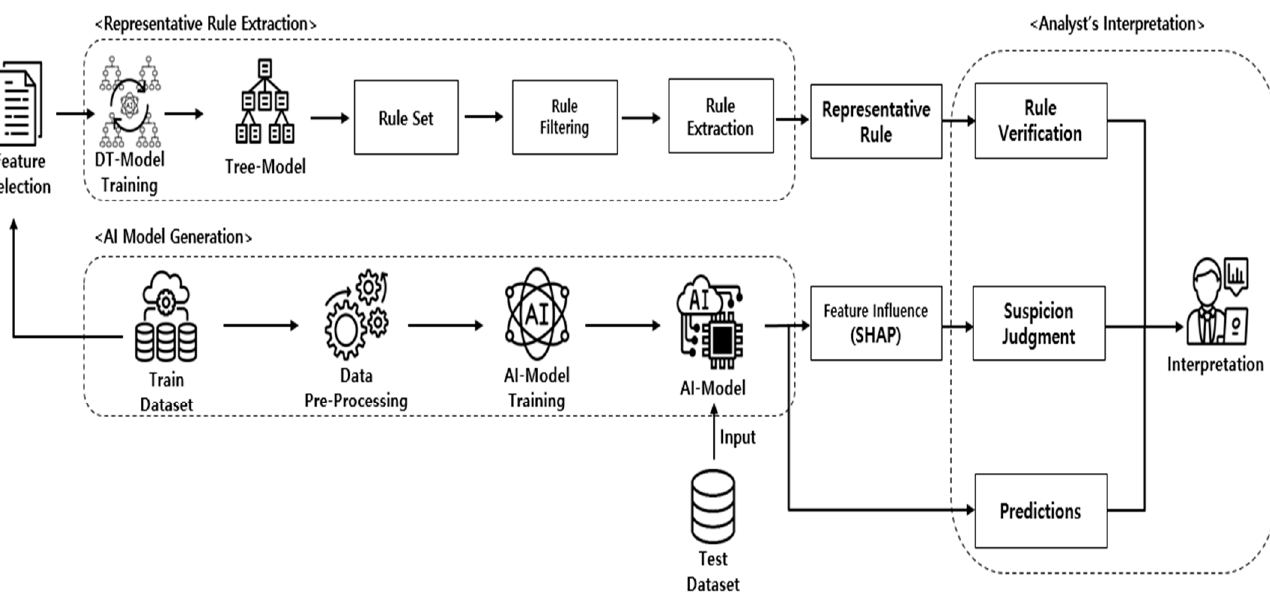
Figure 3. Overall Structure of the Proposed Framework.